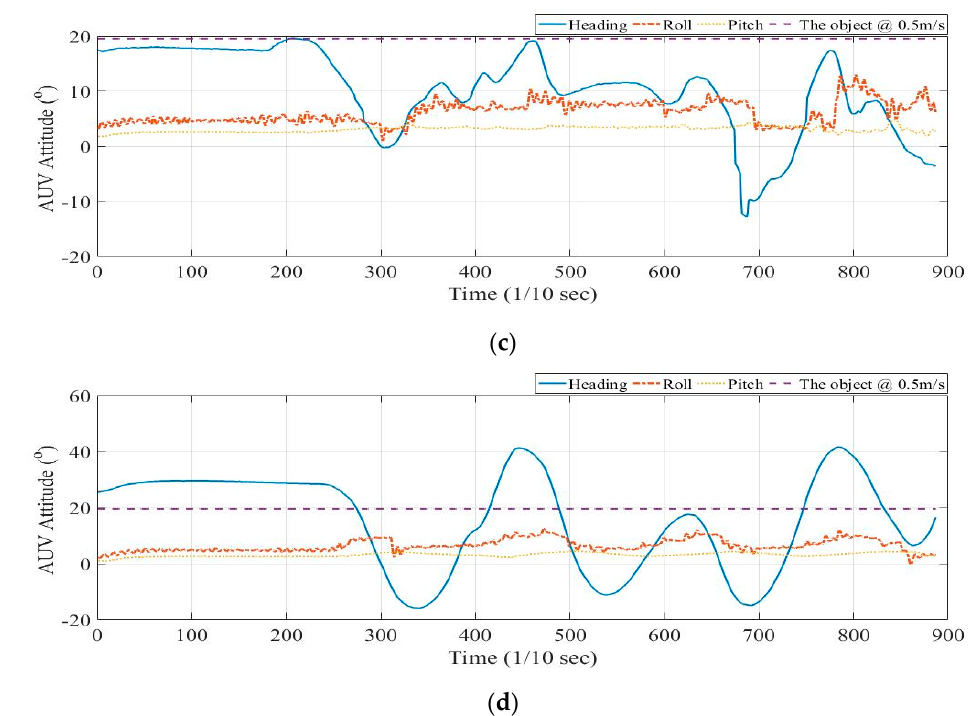
Figure 18. Time histories of AUV attitude at the following target movement speeds: ( a ) 0.1 m/s, ( b ) 0.3 m/s, ( c ) first experiment at 0.5 m/s, and ( d ) second experiment at 0.5 m/s.